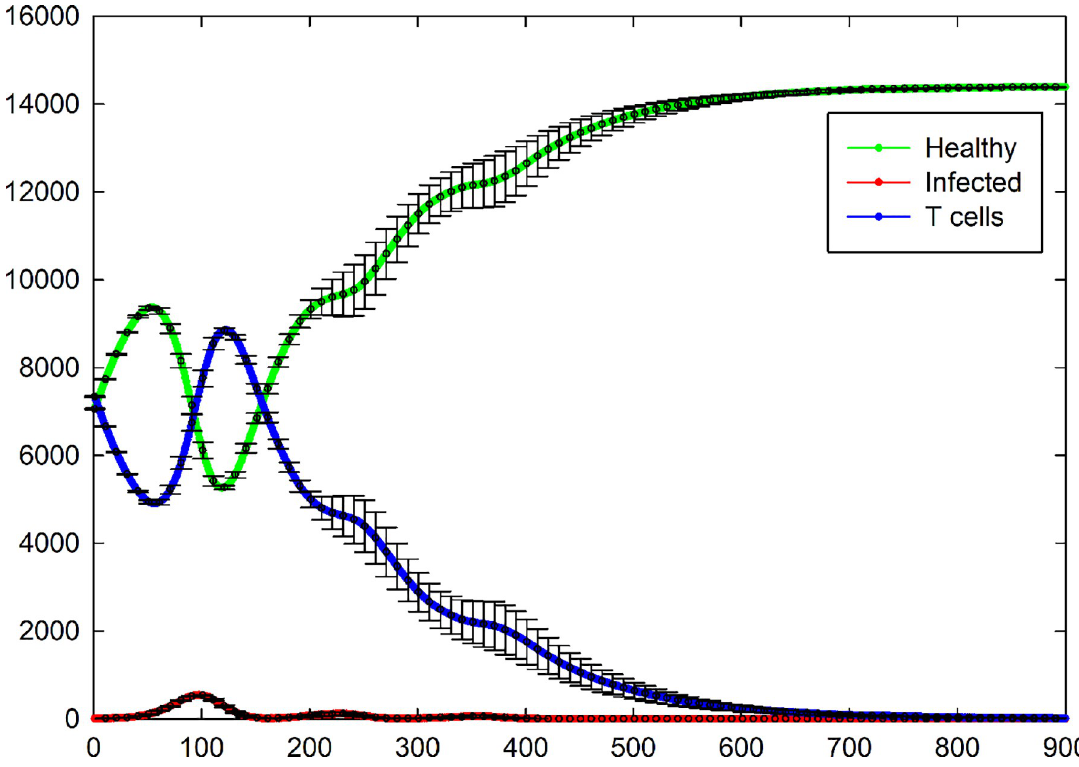
Fig 13. Total number of healthy, infected, and T cells versus time for the case of P I = 1, P T = 0.4, P H = 0.4, and P D = 0.01 without applying diffusion step in transition rules. Healthy, infected, and T cells are shown in green, red, and blue, respectively. The standard errors are shown by error